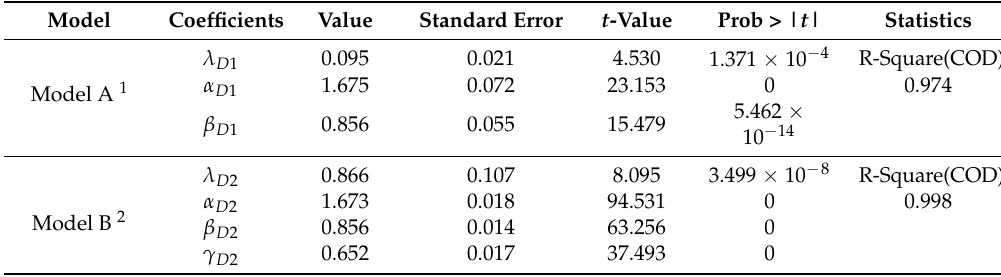
Table 4. ANOVA for material-drilling power of the XHK-714F CNC machining center. Model Items DF Sum of Squares Mean Square F Value Prob > F